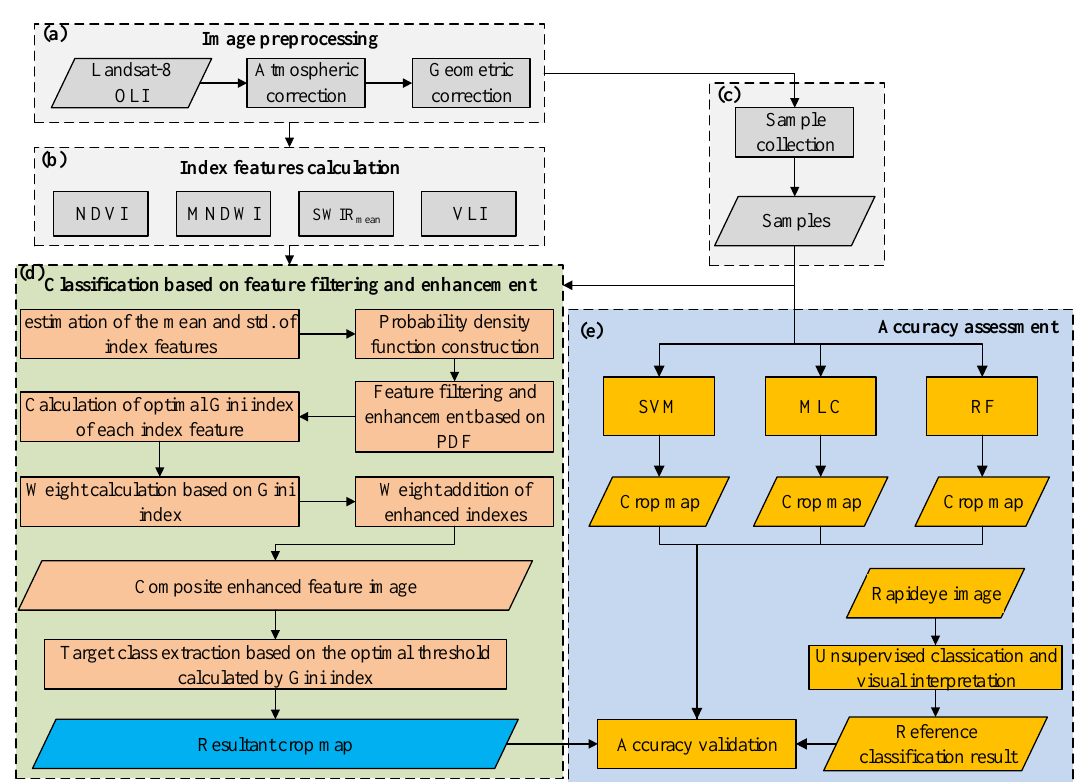
Figure 2. Flowchart of feature filtering and enhancement (FFE)-based crop classification. ( a ) Image processing; ( b ) Index features calculation; ( c ) sample collection; ( d ) classification based on FFE; ( e )